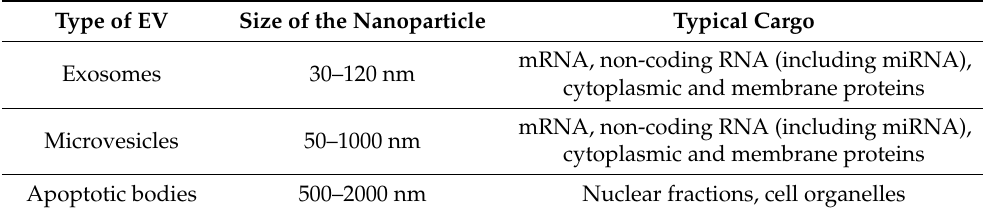
Table 1. Cargo and size differences between different types of EVs